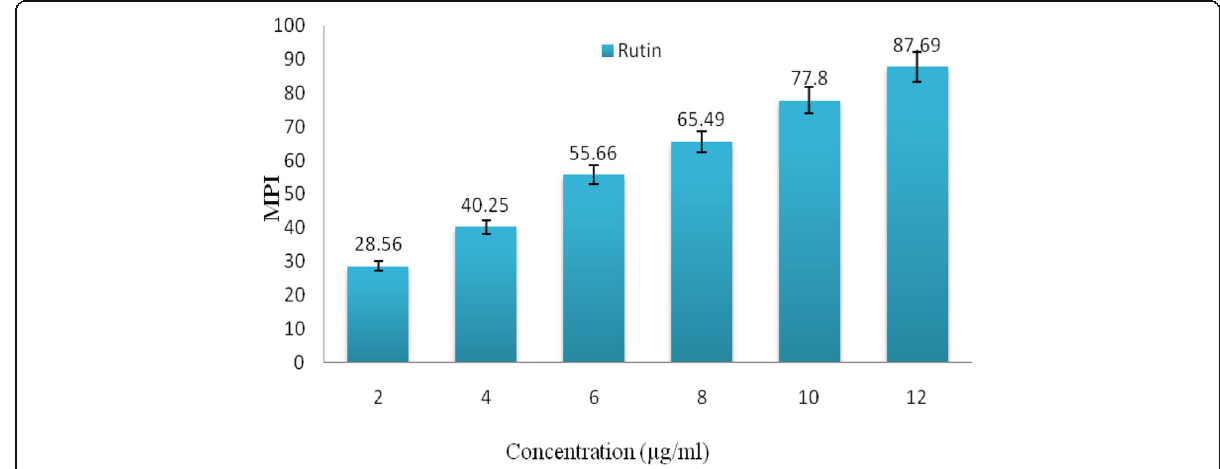
Fig. 3 Graph showing mean percentage inhibition of DPPH by